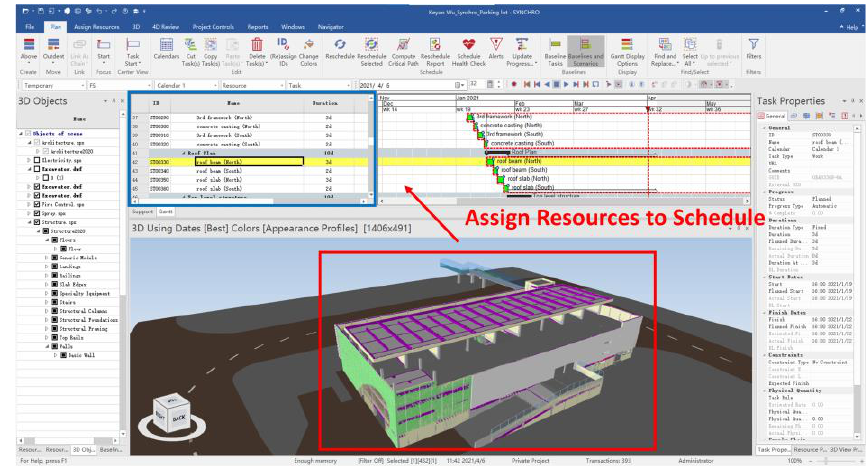
Figure 4. Synchro Pro operation process.